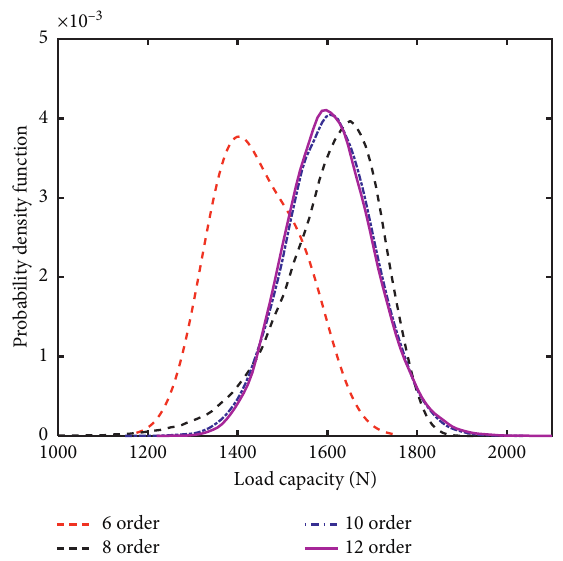
Figure 15: Convergence of the order of